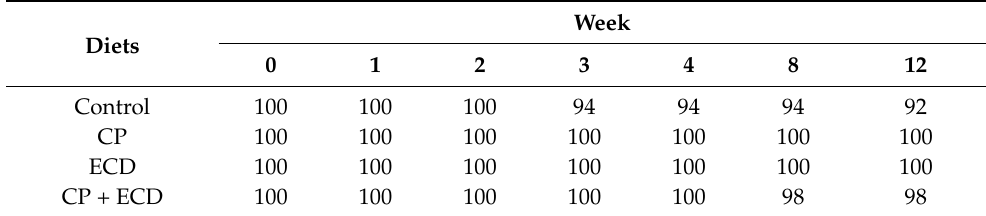
Table 2. Effect of dietary citrus pomace (CP) and Ecklonia cava disuse (ECD) on survival rate (%) of abalone ( H. discus